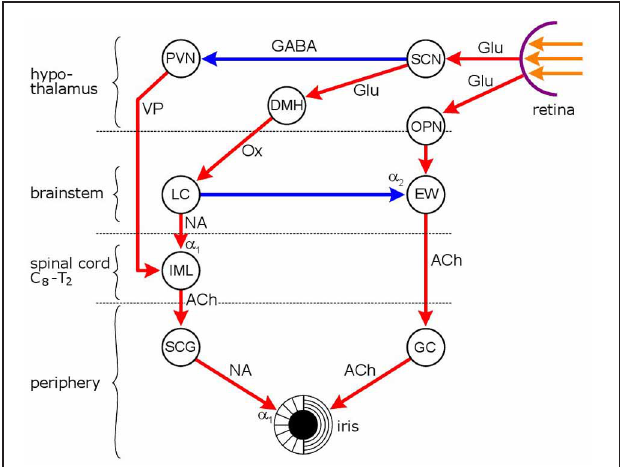
FIGURE 2 | Neuronalnetworkmediatingtheeffectoflightonpupil diameter. Red:excitatoryconnections,blue:inhibitoryconnections. Hypothalamicnuclei:SCN,suprachiasmaticnucleus;PVN,paraventricular nucleus;DMH,dorsomedialhypothalamus;autonomicpremotornuclei: OPN,olivarypretectalnucleus;LC,locuscoeruleus;parasympathetic nucleus/ganglion:EW,EdingerWestphalnucleus;GC,ganglionciliare; sympatheticnucleus/ganglion:IML,intermedio-lateralcolumnofspinalcord; SCG,superiorcervicalganglion.Neurotransmitters:Glu,glutamate;GABA, γ -amino-butyricacid;VP,vasopressin;Ox,orexin;ACh,acetylcholine;NA, noradrenaline.Adrenoceptors: α 1 ,excitatoryand α 2 ,inhibitory.Pupildiameter reflectstherelationshipbetweentwoopposingsmoothmuscles,thedilator pupillae,innervatedbythesympathetic,andsphincter(constrictor)pupillae (innervatedbytheparasympathetic).Thelocuscoeruleusfunctionsasbotha sympatheticandaparasympatheticpremotornucleus:itstimulates preganglionicsympatheticneuronesintheIMLandinhibitspreganglionic parasympatheticneuronesintheEW.Thepupillarylightreflexisa parasympatheticreflex:lightsignalsfromtheretinastimulatethechainOPN → EW → GC,leadingtopupilconstriction.Lightalsohasanindirecteffecton sympatheticactivityviatheSCN:sympatheticactivityisinhibitedviaaninhibitory outputtothePVN.Light-evokedsympatho-inhibition,however,islikelytobe attenuatedbysympatho-excitationmediatiedviatheSCN → DMH →